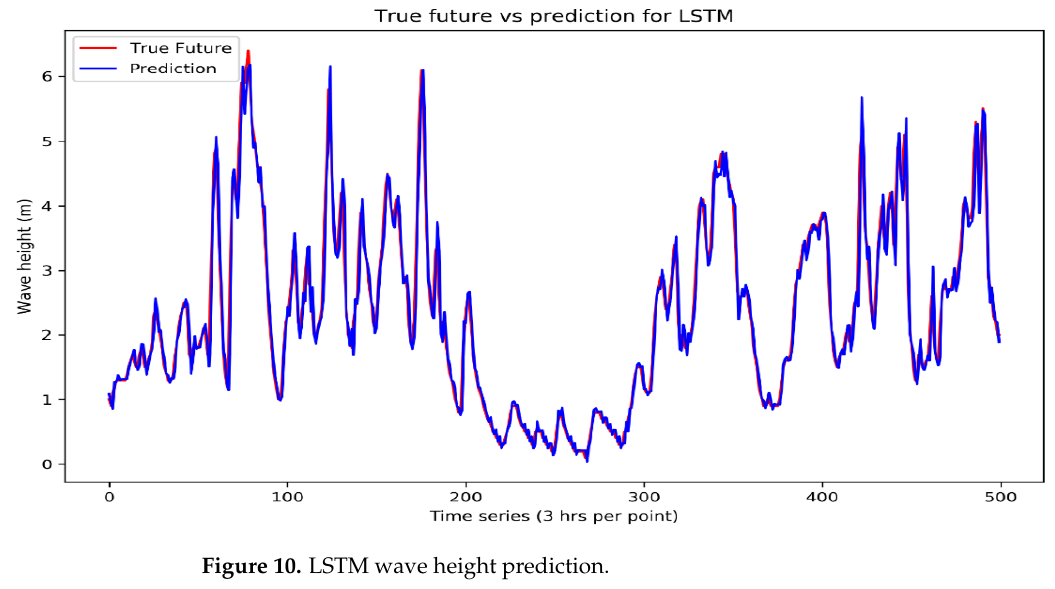
Figure 9. LSTM wind speed prediction.